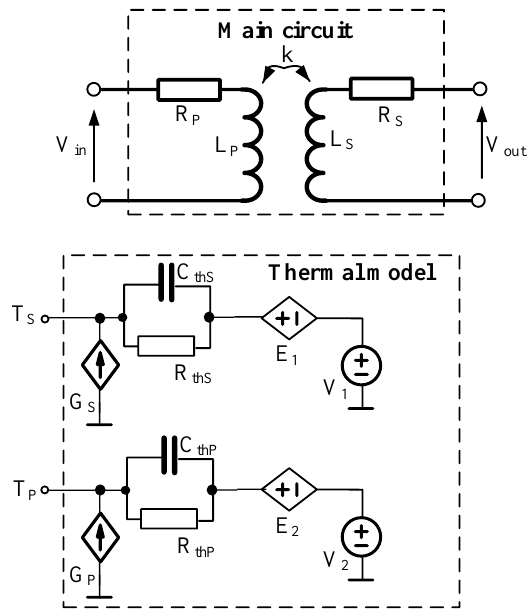
Figure 1. Network representation of the model of an air transformer.